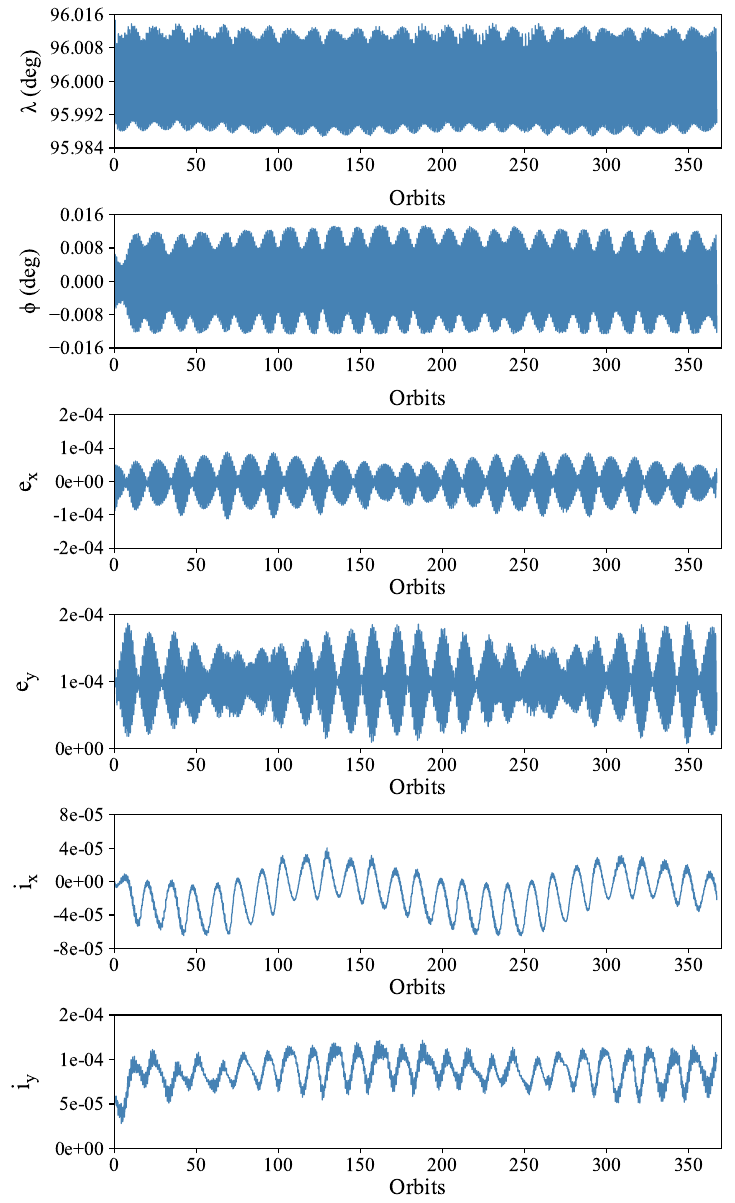
Figure 3. Time history of the osculating elements in the one-year simulation for the FOMPC.